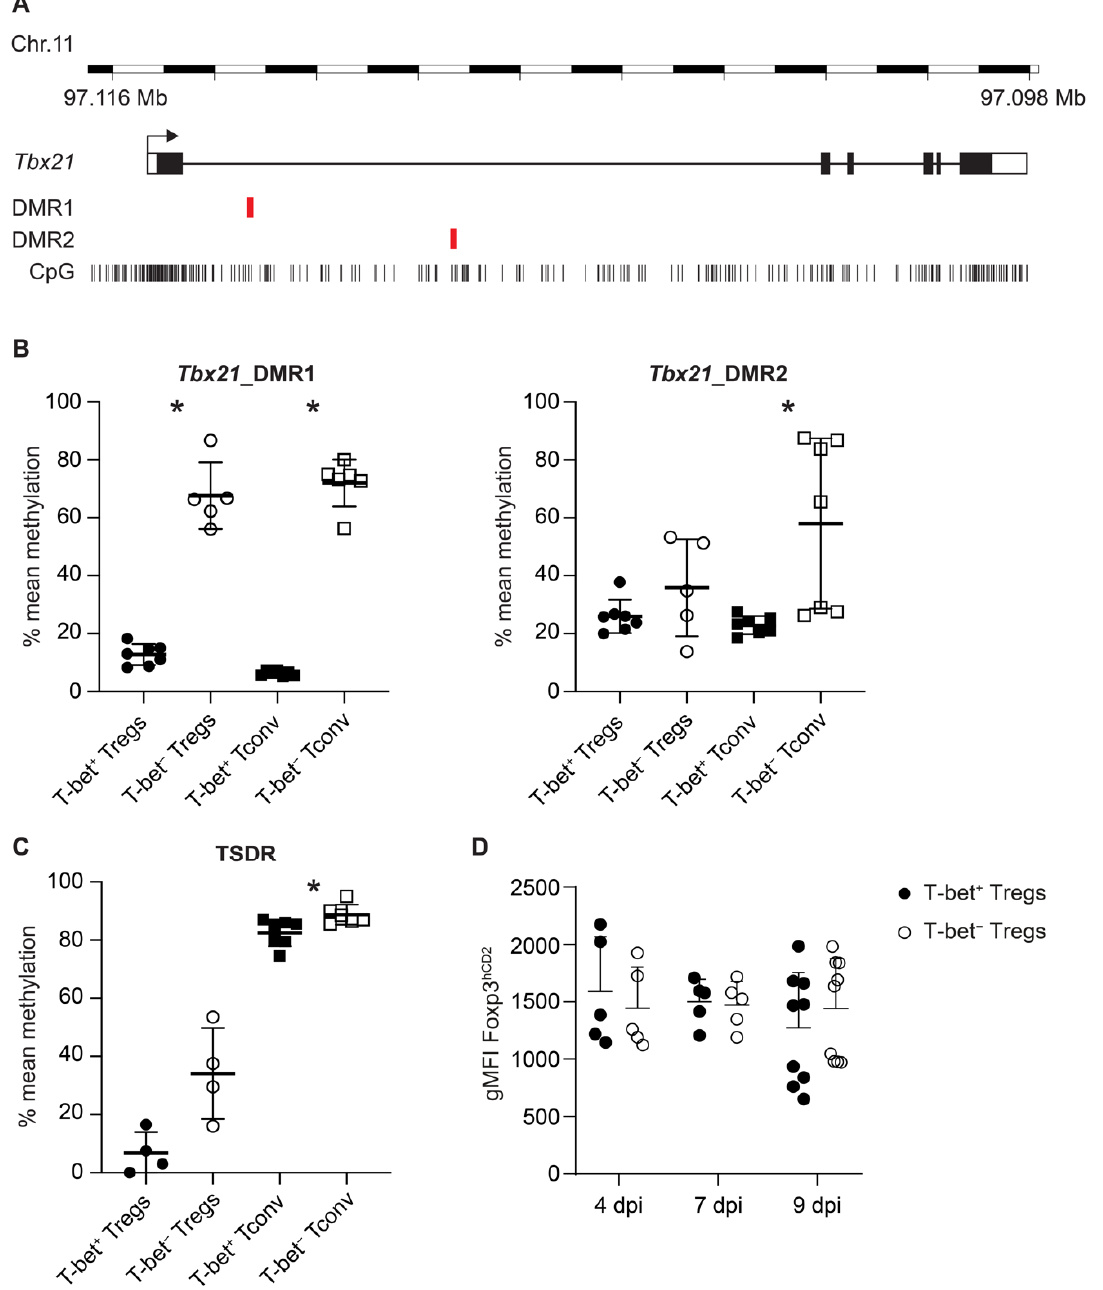
Figure 4. Methylation analysis of Tbx21 DMRs and the TSDR in T-bet + and T-bet − Tregs and Tconv from IAV-infected lungs. ( A ) Schematic overview of the chromosomal localization, gene structure, position of CpG motifs and analyzed DMR1 and DMR2 of the murine Tbx21 gene; ( B , C ) Lungs from IAV-infected animals were collected and prepared at 10 dpi. T-bet + and T-bet − Treg as well as Tconv subsets were immediately sorted by flow cytometry (see Supplementary Figure S1), and genomic DNA was prepared. The methylation status of Tbx21 _DMR1, Tbx21 _DMR2 and the TSDR was determined by pyrosequencing. The graph shows the mean methylation of the indicated regions for individual T-bet + Tregs (black filled circle), T-bet − Tregs (open circle), T-bet + Tconv (black filled square), or T-bet − Tconv (open square) populations. ( D ) Foxp3 expression levels are shown as geometric mean fluorescence intensity (gMFI) of the hCD2 reporter at indicated time points. Each symbol represents data from cells isolated from an individual IAV-infected mouse, and data were pooled from two independent experiments. Mann–Whitney test was used to calculate statistical significance by comparing values from T-bet + Tregs or T-bet + Tconv with T-bet − Tregs or T-bet − Tconv, respectively. Significant changes are indicated by an